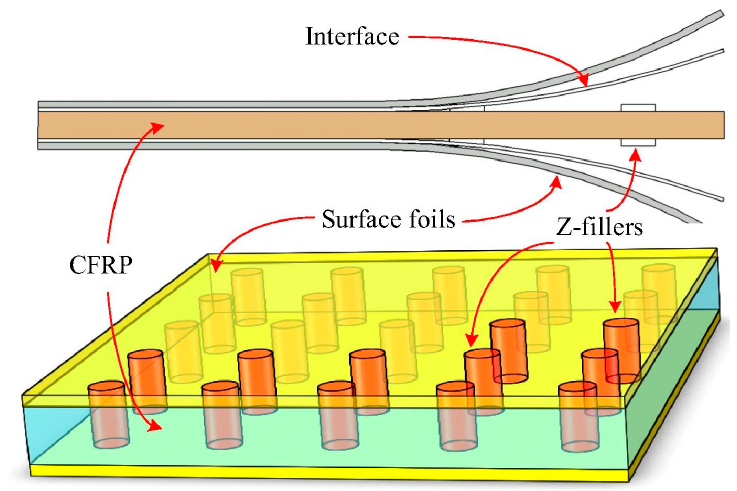
Figure 66. Schematic demonstration of z-filler CFRP laminated composites, adapted with permission from Ref. [265]. Copyright © 2016 Elsevier